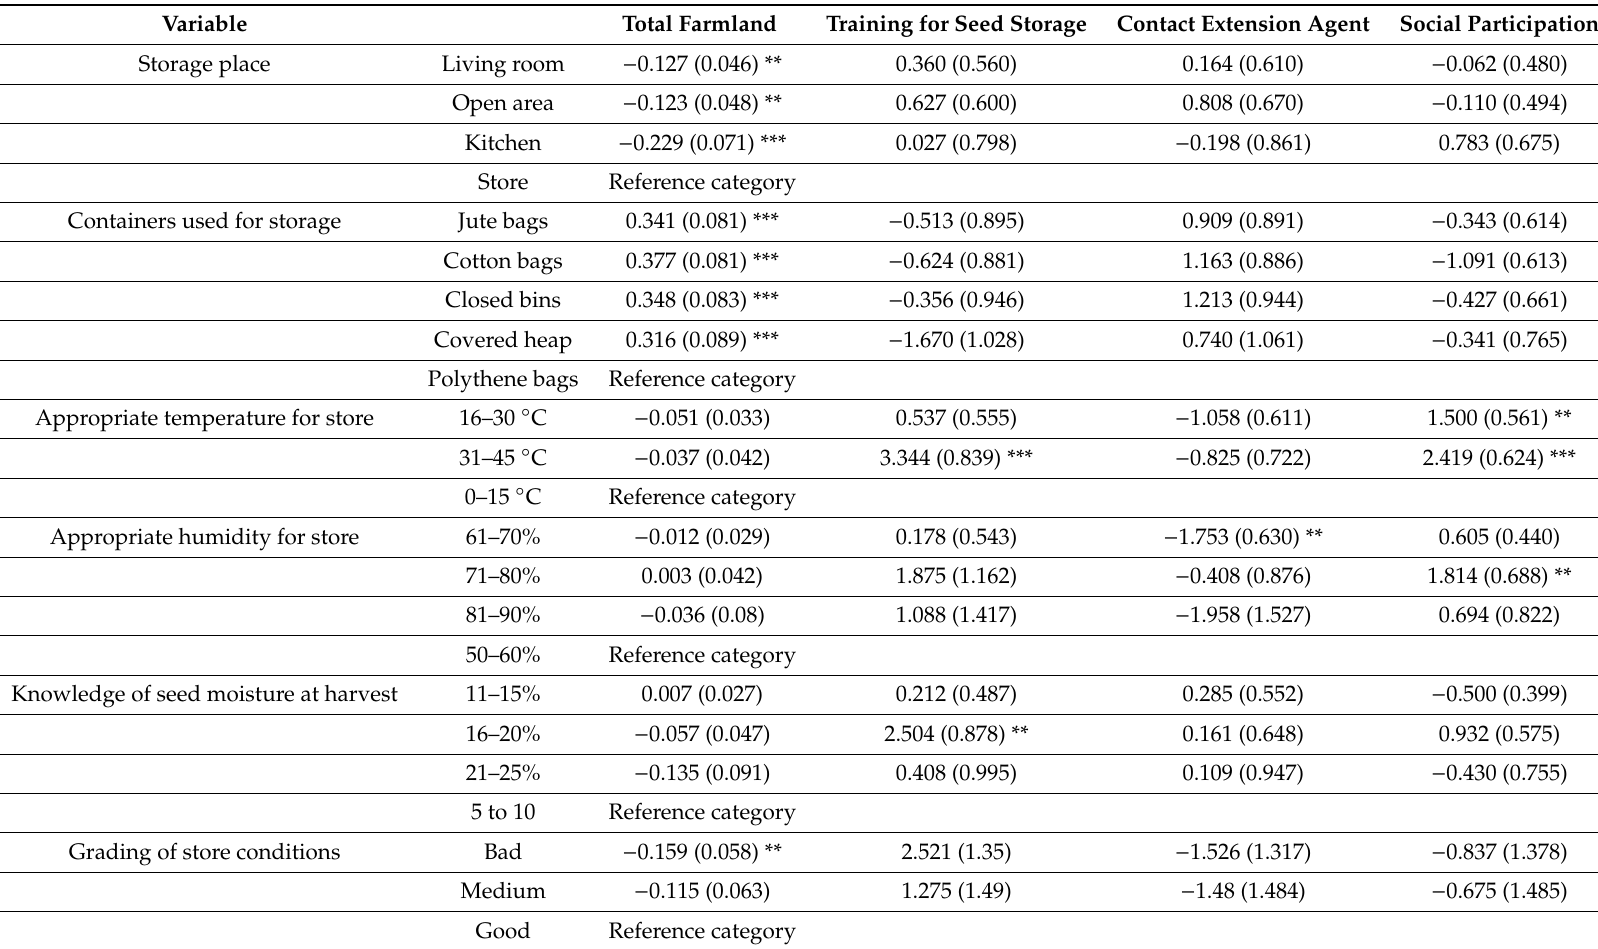
Table 6. Multinomial logistic regression for growers’ perceptions of their abilities to manage seed